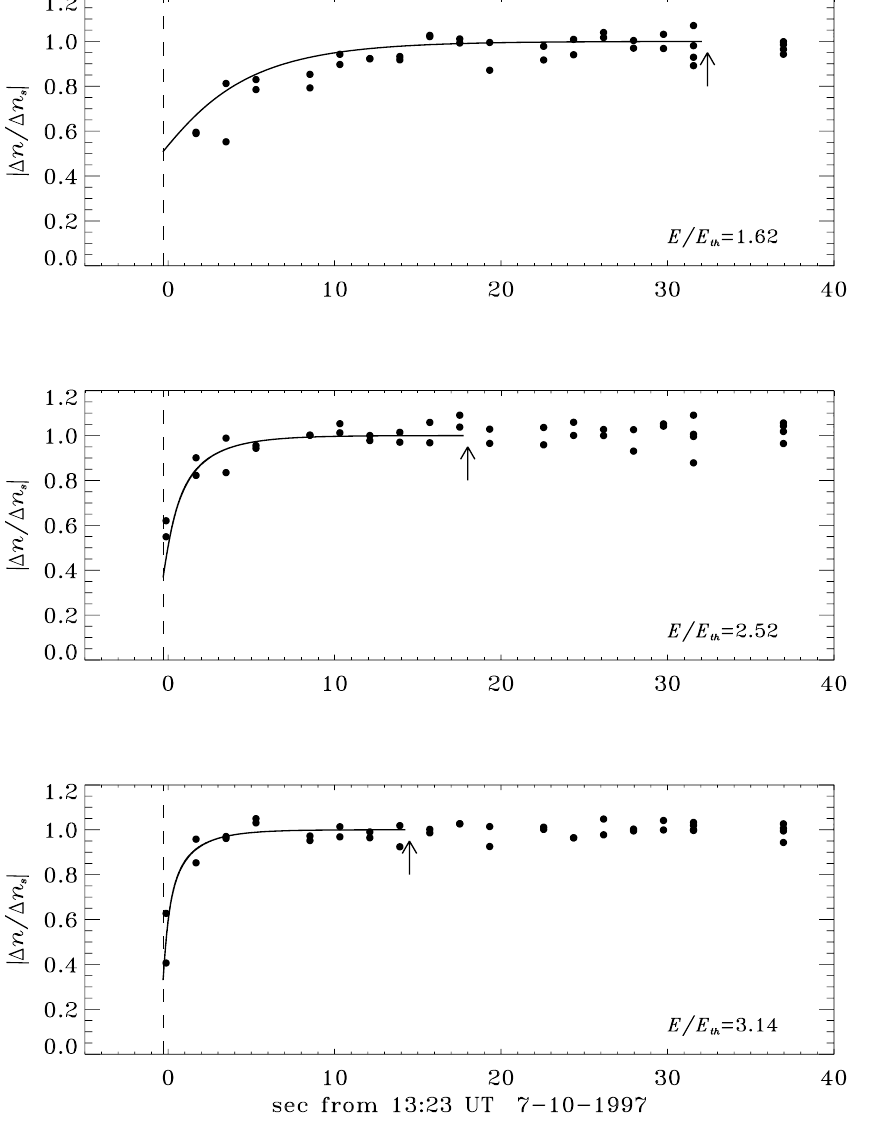
Fig. 4. Density perturbation